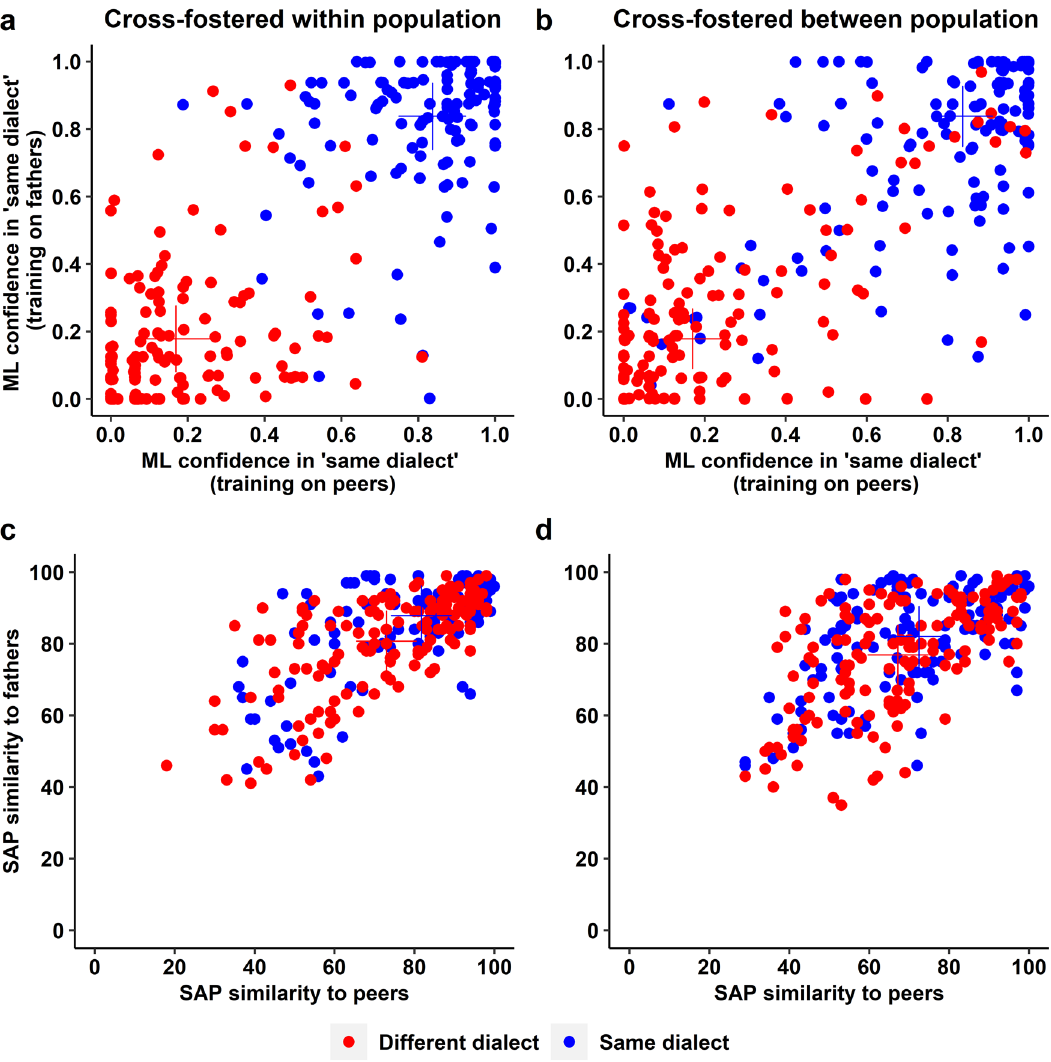
Fig. 7 Classi fi cation scores from a machine-learning algorithm (ML; a, b) and similarity scores from Sound Analysis Pro (SAP; c, d). a , b A machine- learning algorithm was trained on independent sets of zebra fi nch song recordings to discriminate between ‘ same ’ and ‘ different ’ dialect from the perspective of an individual female in Generation 2 given her experiences in a rearing aviary. In the training data set ‘ same ’ is represented either by the songs of the set of 8 fathers (Generation 1) or the set of 10 peer members (Generation 2) in the rearing aviary; ‘ different ’ is represented by the respective songs from an aviary of another population type (domestic D or wild-derived W, by males that will not be encountered in the social or breeding experiment). The 40 males that a female will encounter in the social and breeding experiment (20 of the same song dialect, shown in blue; 20 of a different song dialect, in red) are then classi fi ed by ML as either ‘ same ’ or ‘ different ’ with complementary con fi dence scores that add up to one. Note that each male contributes 4 data points (2 ‘ same ’ and 2 ‘ different ’ ) because he encounters four types of females (DD, DW, WD, WW) from different rearing aviaries. c , d Similarity scores from SAP using the same representation as in ( a ) and ( b ) (similarity to the songs of the peers or fathers of a female ’ s rearing aviary, which the focal male never met, such that any similarity is indirect). The machine-learning algorithm ( a , b ) achieves much clearer differentiation compared to the traditional SAP software ( c , d ). Males that were cross-fostered within population (DD or WW; a , c ) are discriminated with slightly higher con fi dence than DW or WD males ( b , d ; see the crosses that mark the group